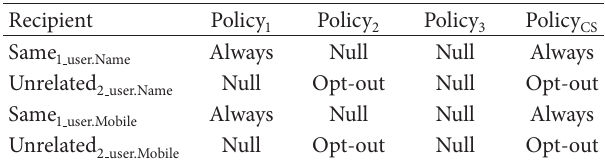
Table 10: Required values of Recipient values in TravelBroker.